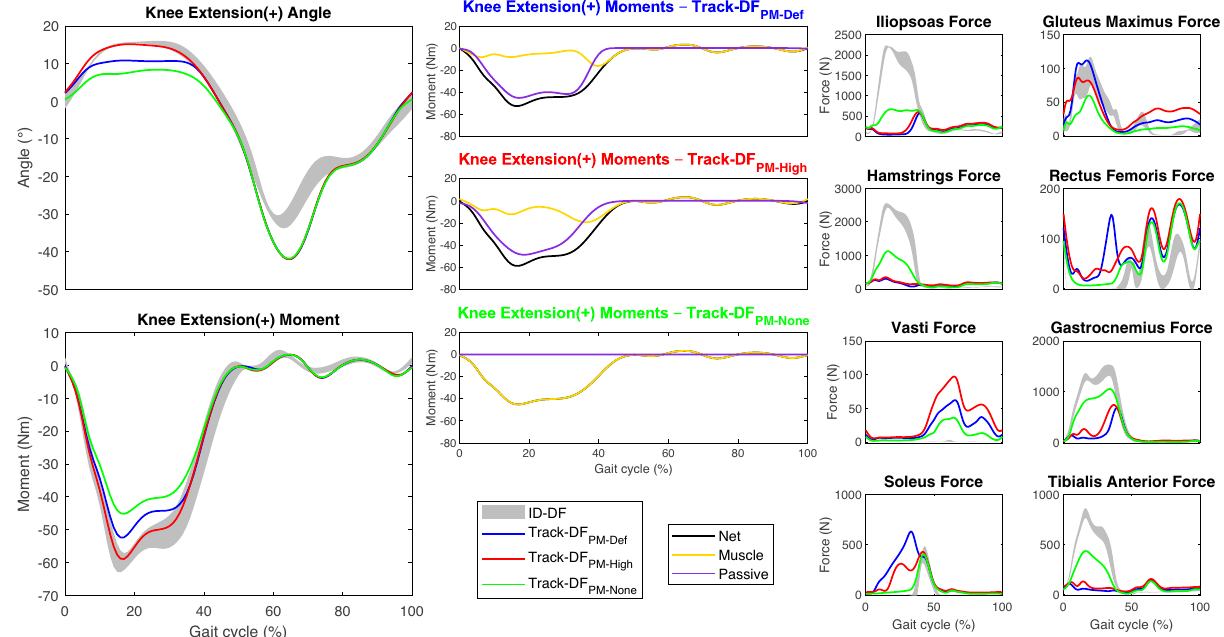
Figure 1. Influence of passive knee moment on the ID (mean ± standard deviation) and tracking of gait in the DF condition (ipsilateral knee angle, moments, and major muscle